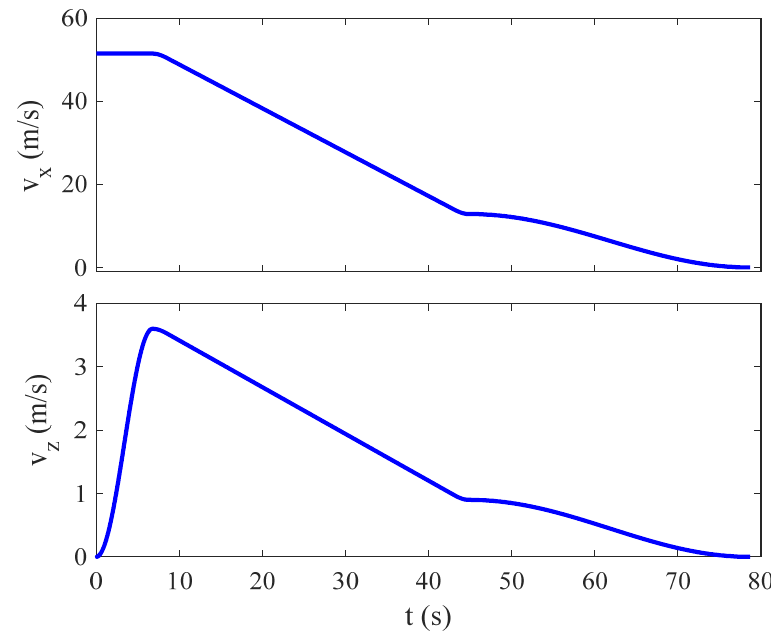
Figure 13. Time profiles of desired velocities of aircraft.